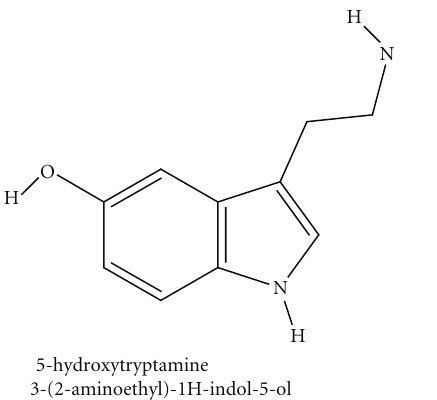
Figure 1: Serotonin (5-HT). Modified image from NCBI PubChem Substance Database CID 5202.